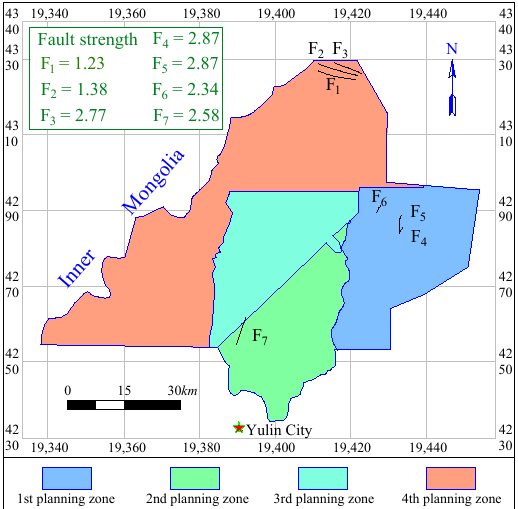
Figure 11. Distribution of the seven faults and the fault strength in the Yu-Shen mining area.